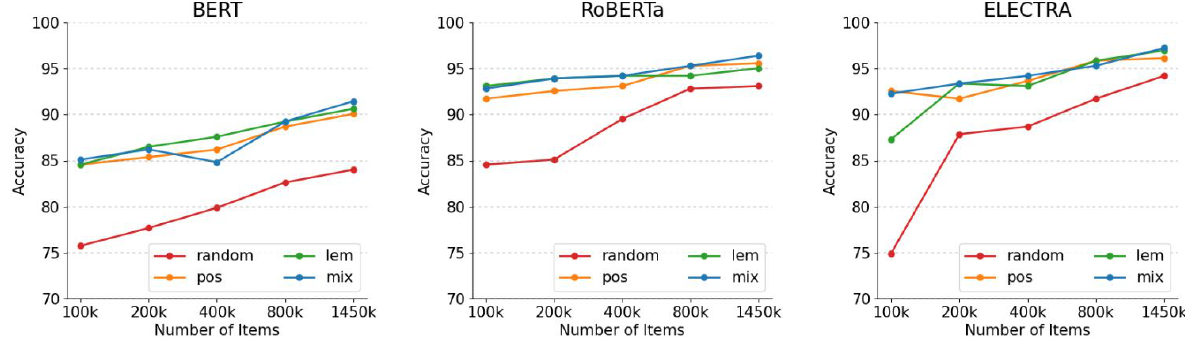
Figure 3. BERT, RoBERTa, and ELECTRA performance variation according to the data